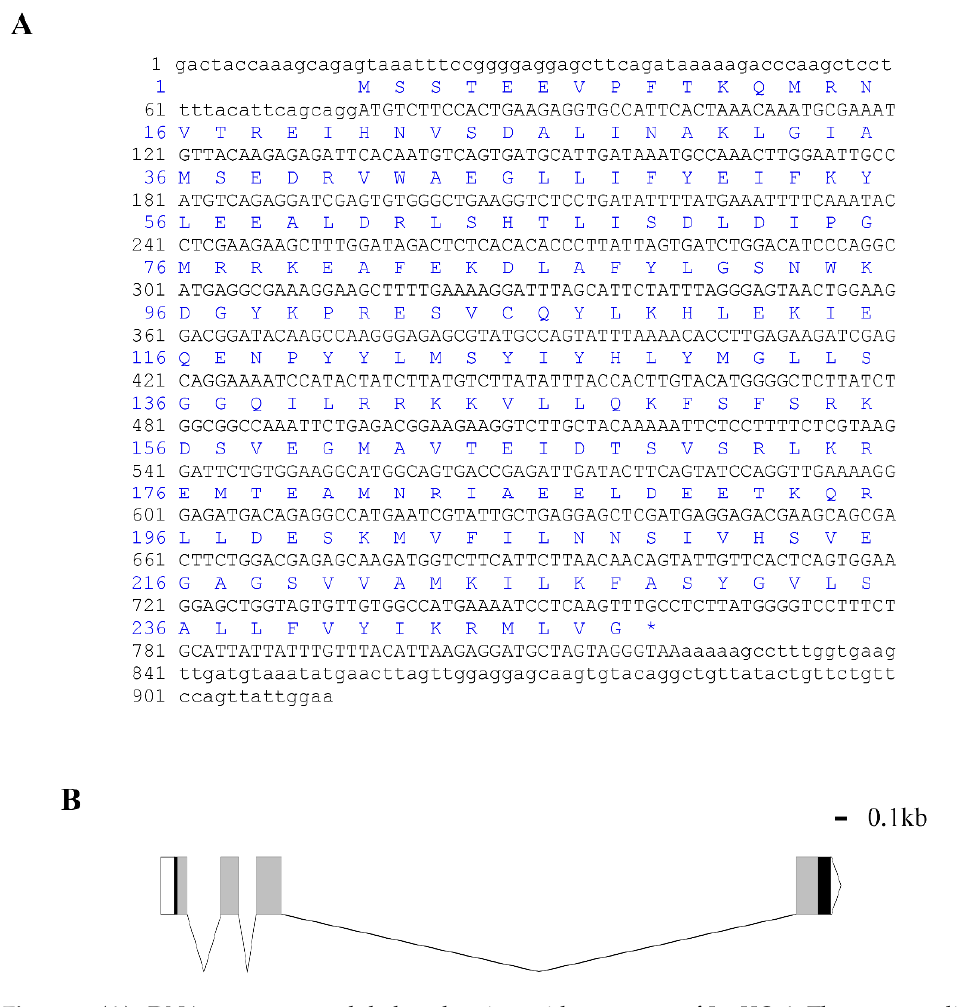
Figure 1. ( A ) cDNA sequences and deduced amino acid sequences of Lv-HO-1 . The open reading frame (ORF) is capitalized. An asterisk indicates the stop codon. ( B ) Genomic structure of Lv-HO-1 contains three introns and four exons. Untranslated sections are marked with a white box (UTR).